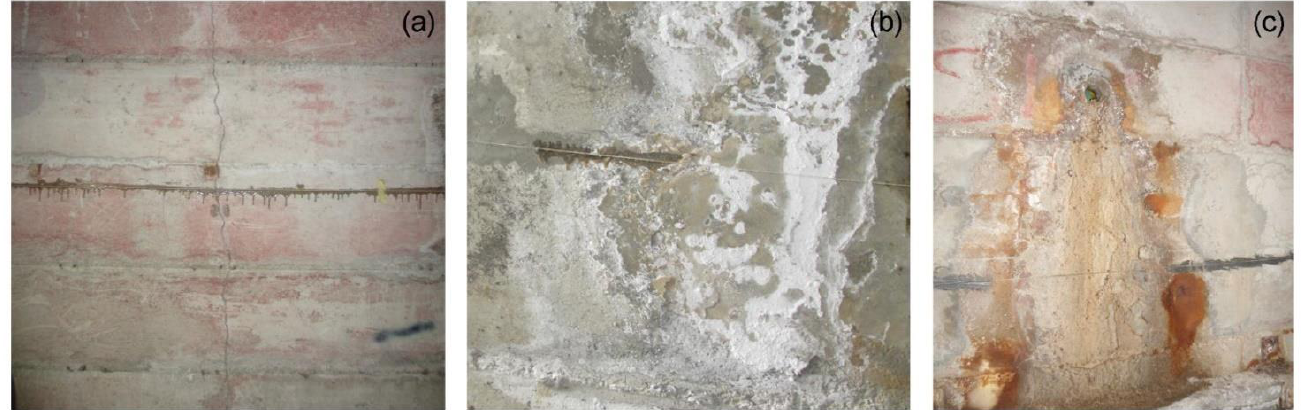
Figure 11. ( a ) Crack on the tunnel wall; ( b ) parget swelling; ( c ) salt precipitate accumulation (from Ref. [66]).